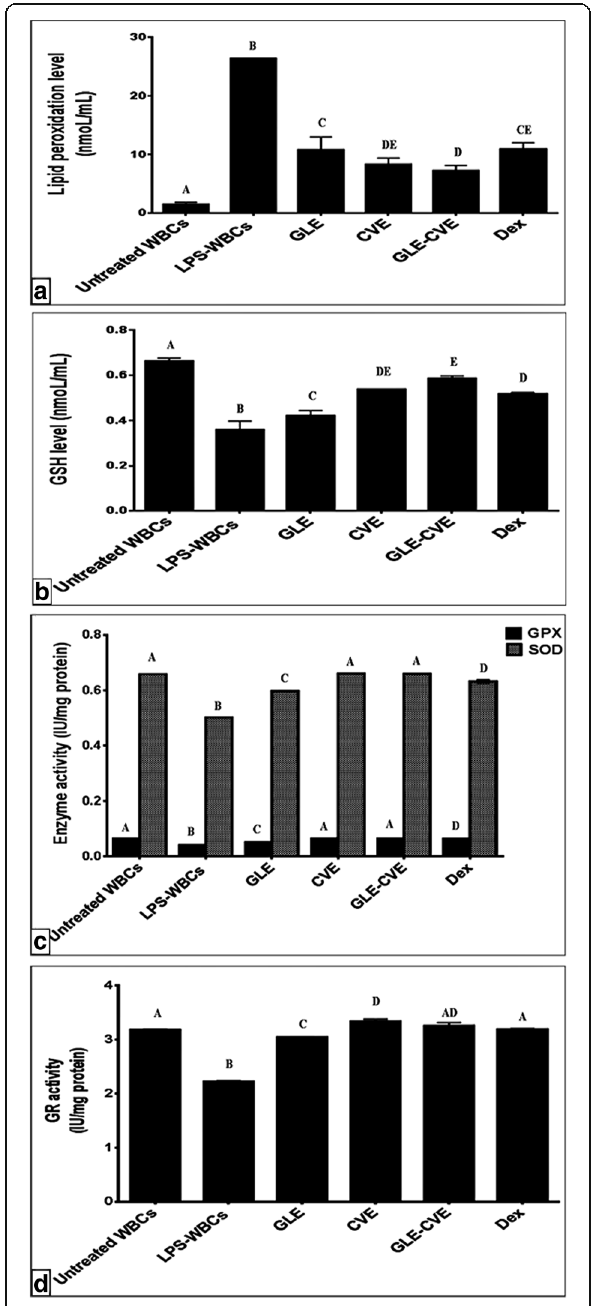
Fig. 5 Effect of GLE, CVE, GLE-CVE, and Dex on LPS-induced oxida- tive stress in WBCs. (a) lipid peroxidation level (b) reduced glutathi- one (GSH) level (c) glutathione peroxidase (GPX) and superoxide dismutase (SOD) activities (d) glutathione reductase (GR) activity. Re- sults are expressed as Mean ± S.E. Different letters for the same par- ameter are significantly different at p <